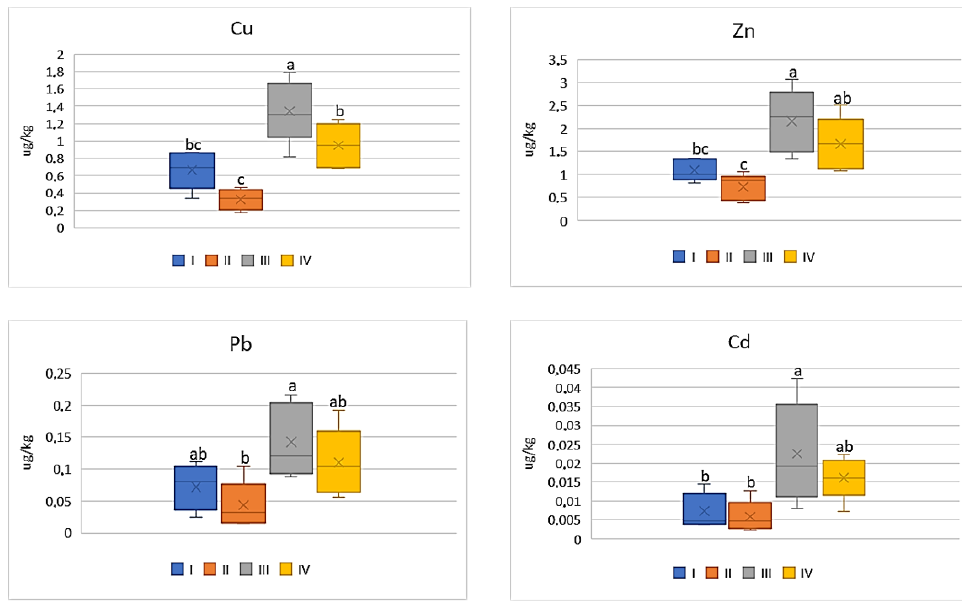
Figure 10. DIM values for cabbage depending on the metal and study zones. The same letters mean no significant differences between the values.